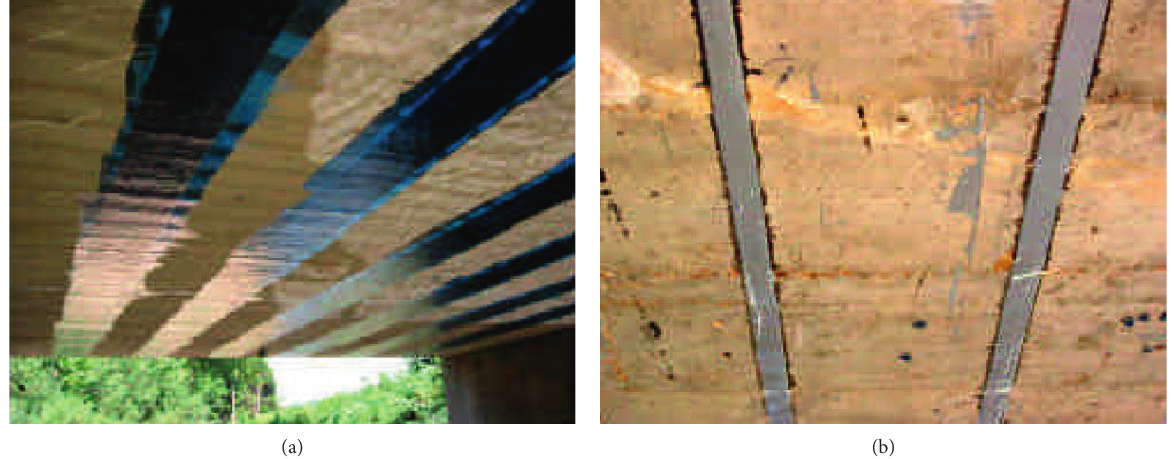
Figure 8: Externally bonded FRP laminates (a) and NSM FRP bars (b)